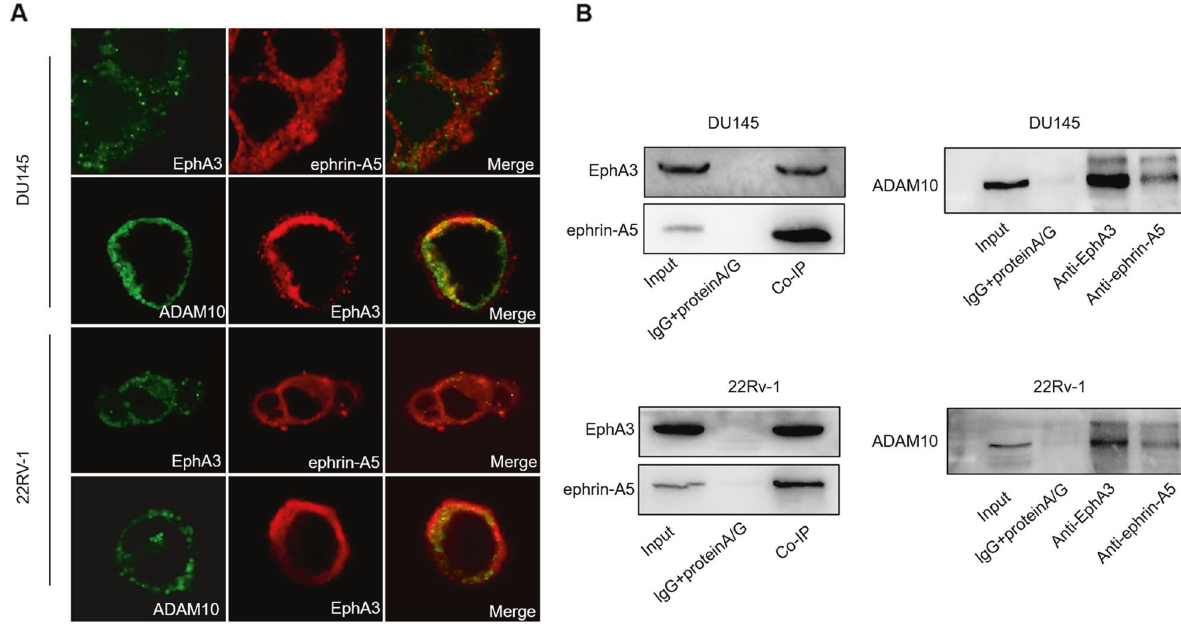
Fig. 3 Interaction of ADAM10, EphA3, ephrin-A5 in cells. A Detection of cellular localization of ADAM10, EphA3, and ephrin-A5 by Immuno fl uorescence in DU145(top) and 22Rv-1(bottom). B The interaction of EphA3, ephrin-A5 and ADAM10 proteins was detected by co- immunoprecipitation in DU145(top) and 22Rv-1(bottom). Input: positive control, lgG + proteinA/G: negative control, Co-IP: using anti-EphA3 antibody or anti-ephrin-A5 antibody to detect